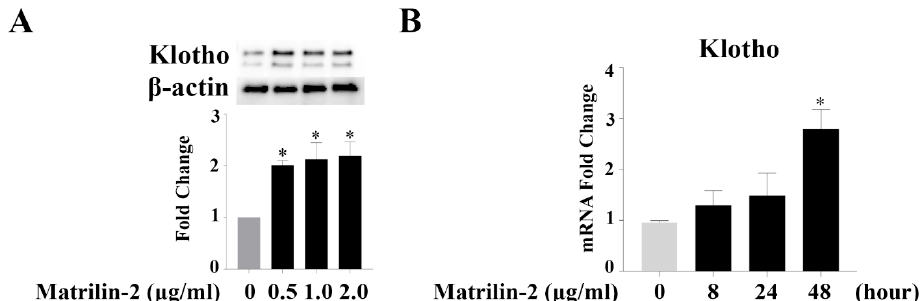
Figure 5. Human AVICs express Klotho. ( A ) Klotho protein is present in human AVICs and is upregulated by matrilin-2 stimulation for 48 h. ( B ) Klotho mRNA is detectable in human AVICs and increases in a time-dependent manner following matrilin-2 stimulation. Values are means ± SE. n = 3 separate experiments; * P < 0.05 vs. control.